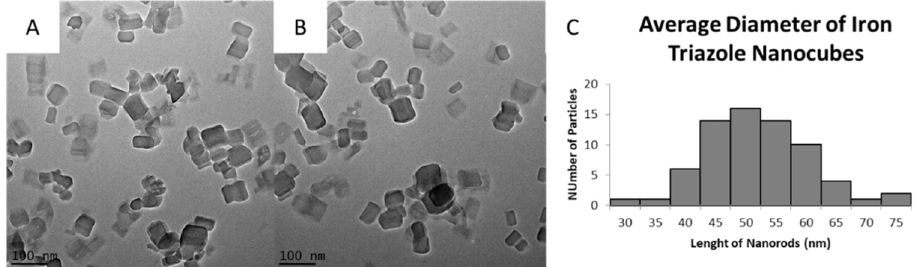
Figure 2. [Fe(Htrz) 2 (trz)](BF 4 )] nanocubes synthesized using the optimal method developed by adaptation of a known reverse micelle approach. ( A , B ) are from the same sample and separate cubic particles can be seen, along with some agglomerated particles. ( C ) is the particle’s distribution for the average diameter of the nanoparticles obtained in ( A , B ).